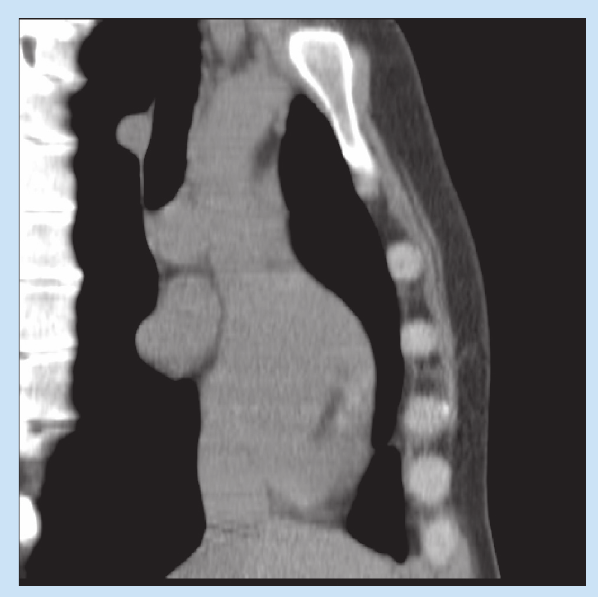
Fig. 4. Sternalis muscle sagittal CT